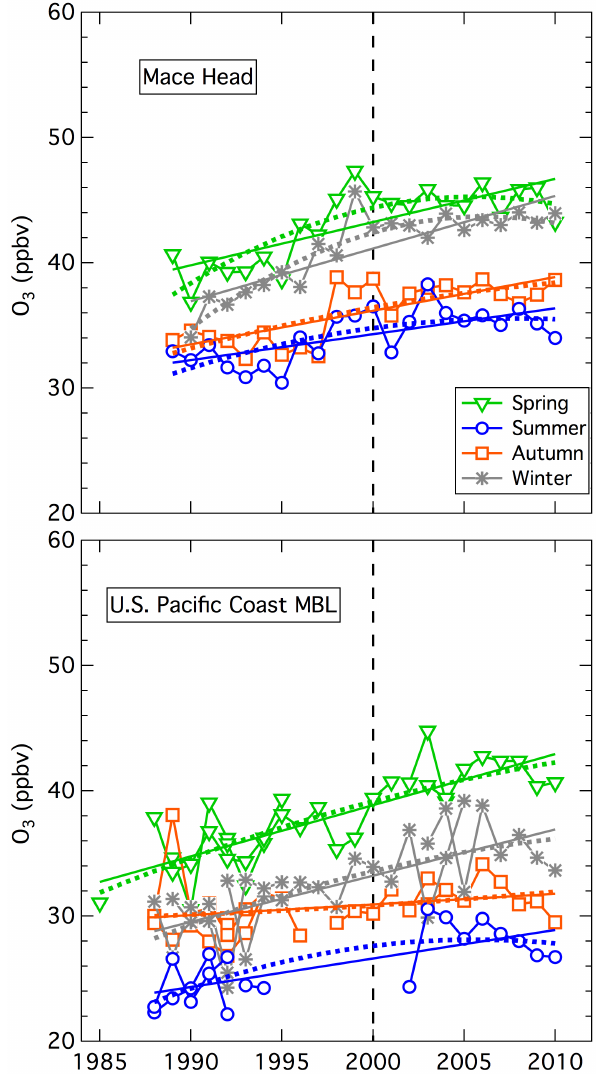
Fig. 3. Seasonal O 3 averages measured in the European marine boundary layer (MBL) at Mace Head, Ireland, and in the North American MBL along the US Pacific Coast. Lines indicate linear and quadratic regressions for the complete data sets in the same for- mat as Fig.